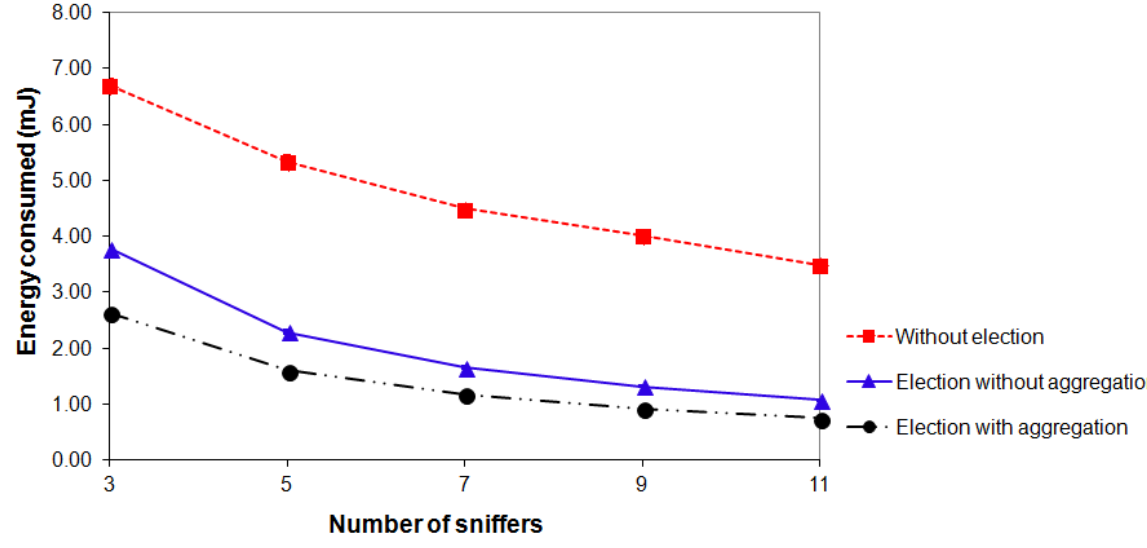
Figure 14. Energy consumed by each sniffer vs . number of